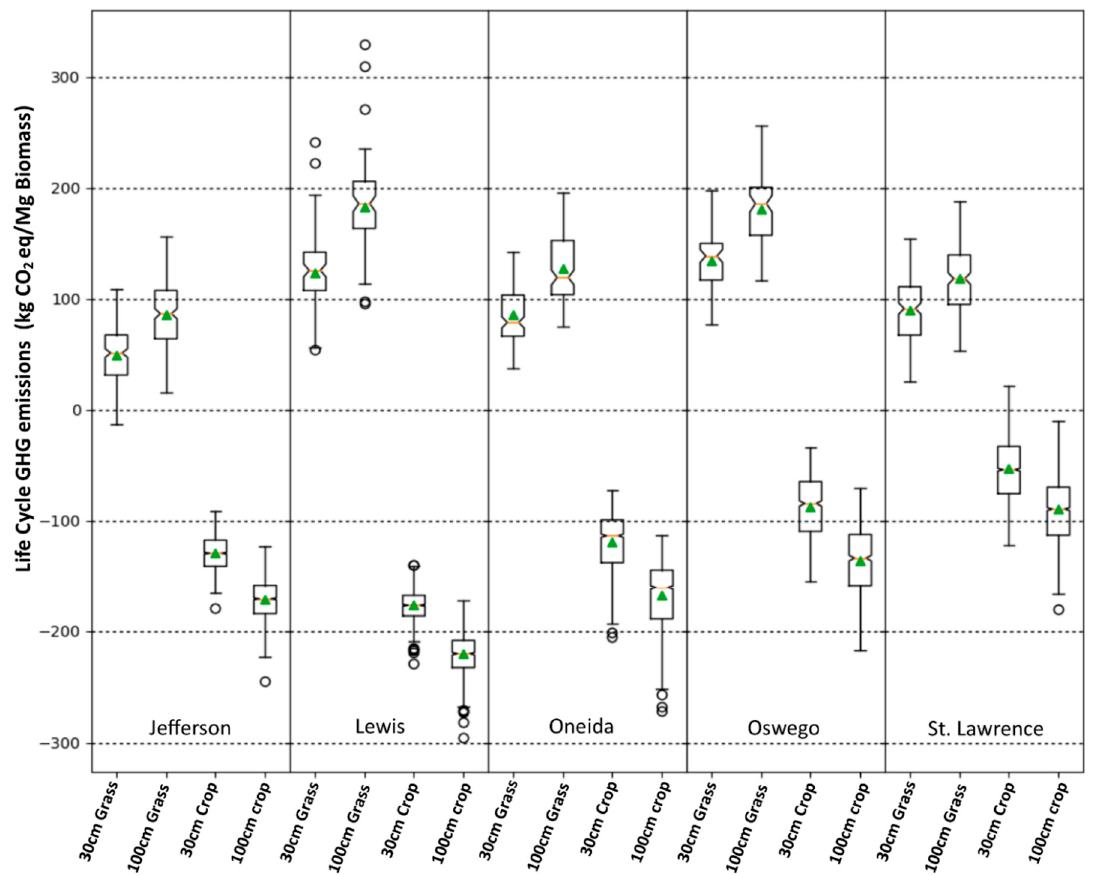
Figure 6. Boxplots showing distributions of willow biomass crop life cycle GHG emissions from parcel level LCA results in five counties in upstate NY. The upper bound, the notch, and lower bound represent 75th percentile, median, and 25th percentile, respectively. The green triangle indicates the mean.